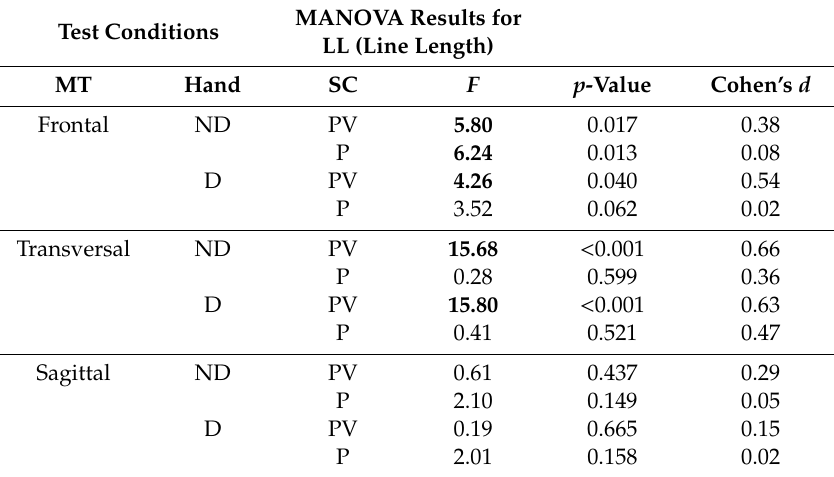
Table 1. MANOVA analyses results for the factor “sex”.